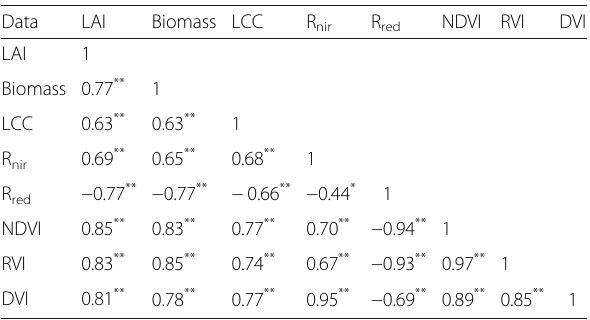
Table 3 Correlation coefficients between agronomic indicators and remote sensing spectral index of winter wheat Data